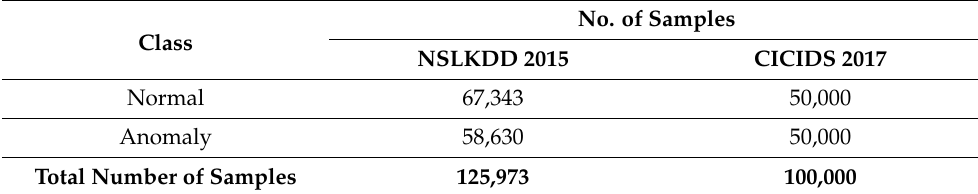
Table 1. Details dataset.